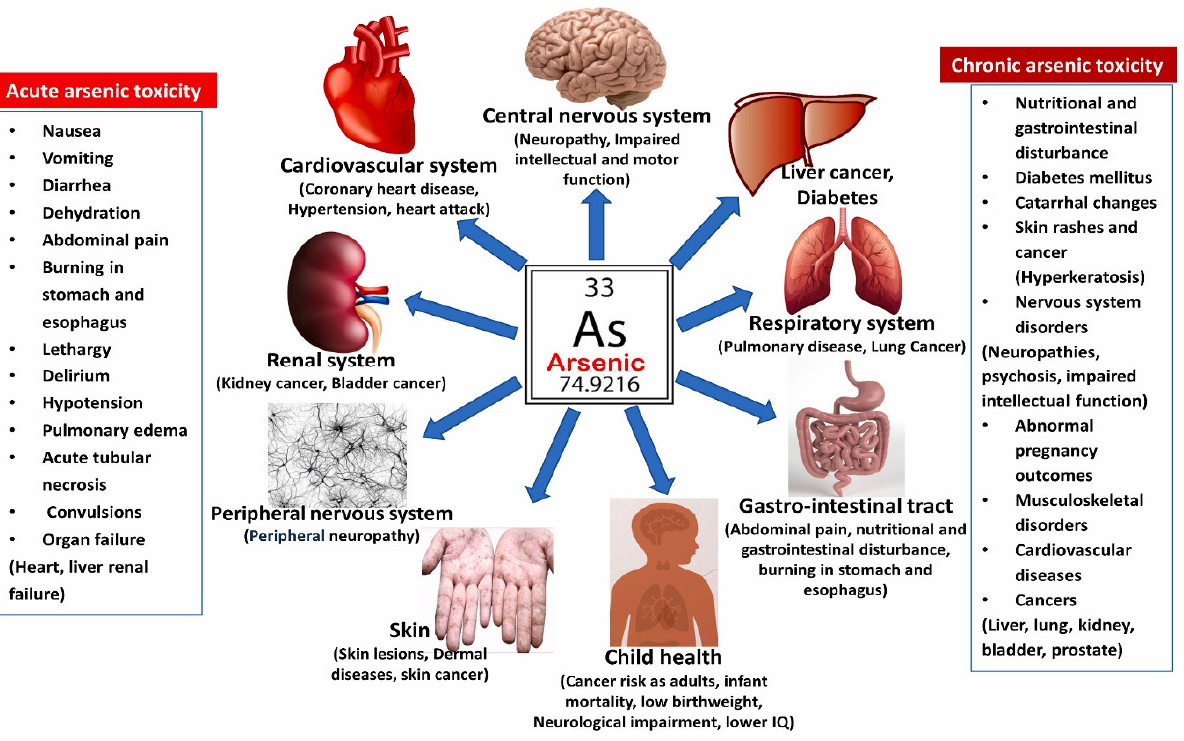
Figure 3. Health effects of arsenic contamination [59] . Figure 2. Health effects of arsenic contamination [59]. Table 2. Common diseases caused by exposure to arsenic. Table 2. Common diseases caused by exposure to